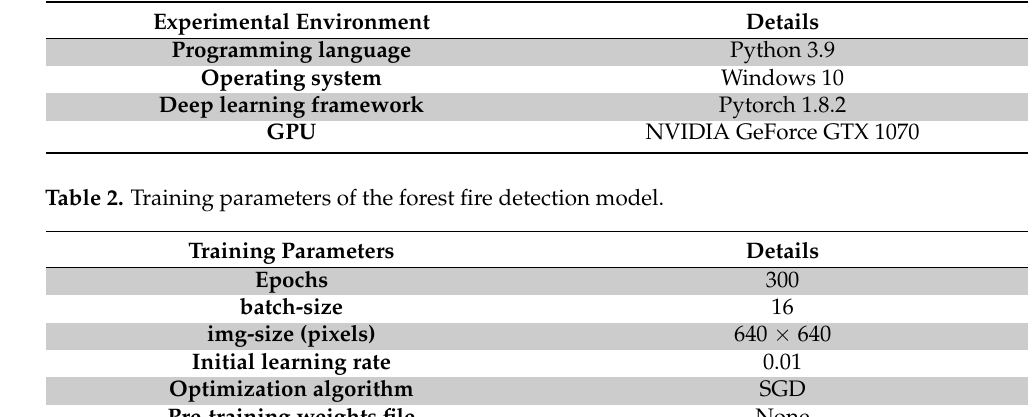
Table 1. Experimental conditions.